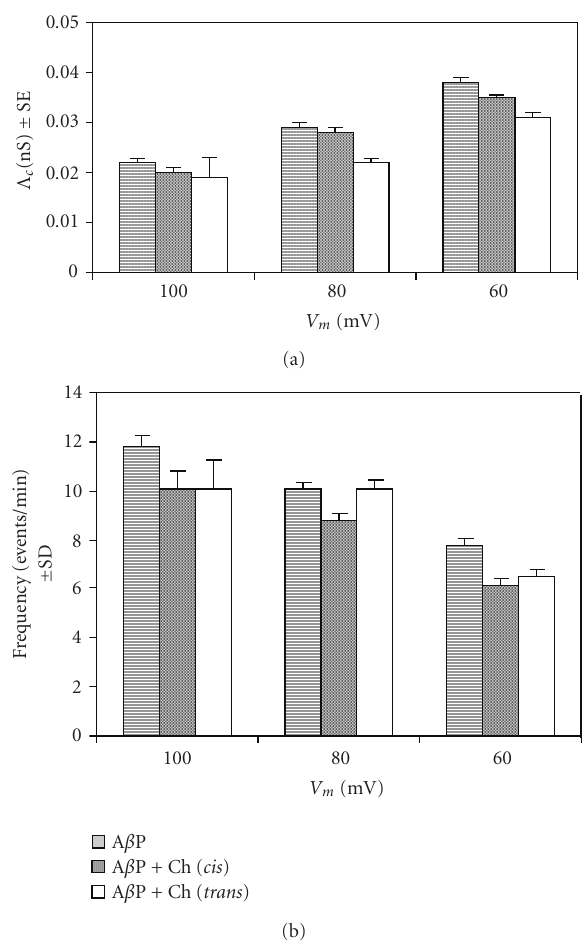
Figure 6: A β P1-40 channel mean conductance and frequency in POPC:Ch PLM. (a) Λ c ± SE and (b) frequency ± SD of A β P1-40 channel without and with choline (5 × 10 − 11 M) (added to the cis or trans side of the chamber) in POPC:Ch (65: 35, w/w) PLM. The minimum and maximum number of channels considered ( N ) out of a total number of channels considered ( N t ) was: A β P1-40, 761 < N < 1283, N t = 2928; A β P1-40 + choline cis, 449 < N < 1320, N t = 2305; A β P1-40 + choline trans , 170 < N < 624, N t = 1269.